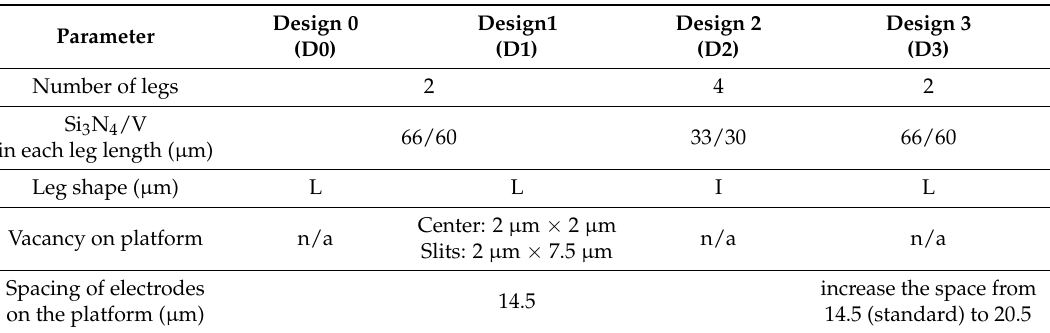
Table 2. The significant differences in specifications of design 0 to 3 device structure for